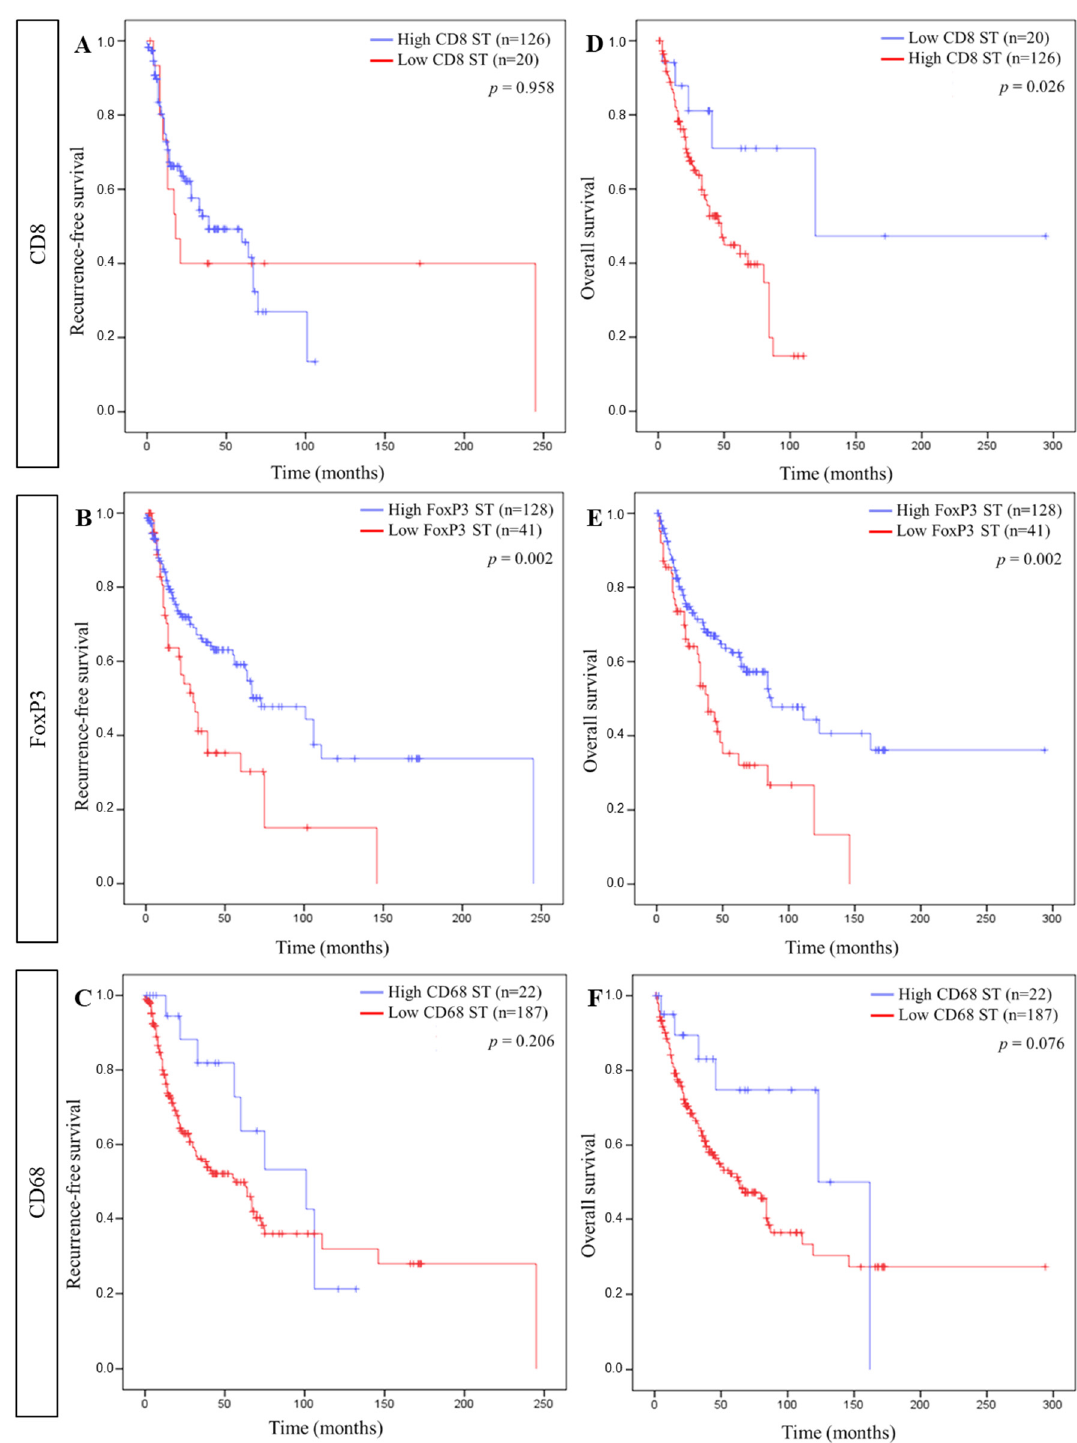
Figure 3. Association between stromal immune cells and patient survival. Kaplan–Meier curves comparing (( A ), ( B ) , and ( C ), respectively) recurrence-free survival (RFS) and CD8, FoxP3, and CD68 and (( D ), ( E ) , and ( F ), respectively) overall survival (OS) and CD8, FoxP3, and CD68 in the stromal compartment (ST).